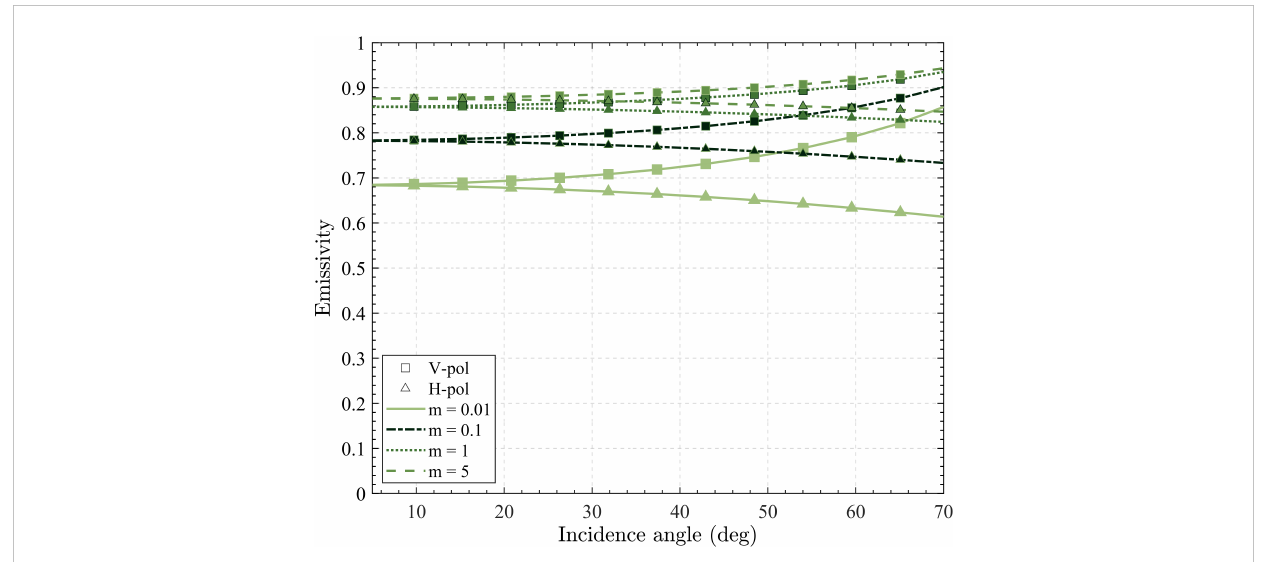
FIGURE 5 Foam emissivity as a function of incidence angle for different void fraction pro fi les at 1.4 GHz (input parameters: water temperature = 20°C salinity = 34 psu, and foam thickness z = 1 cm). V-pol (triangle symbols) and H-pol (square symbols).